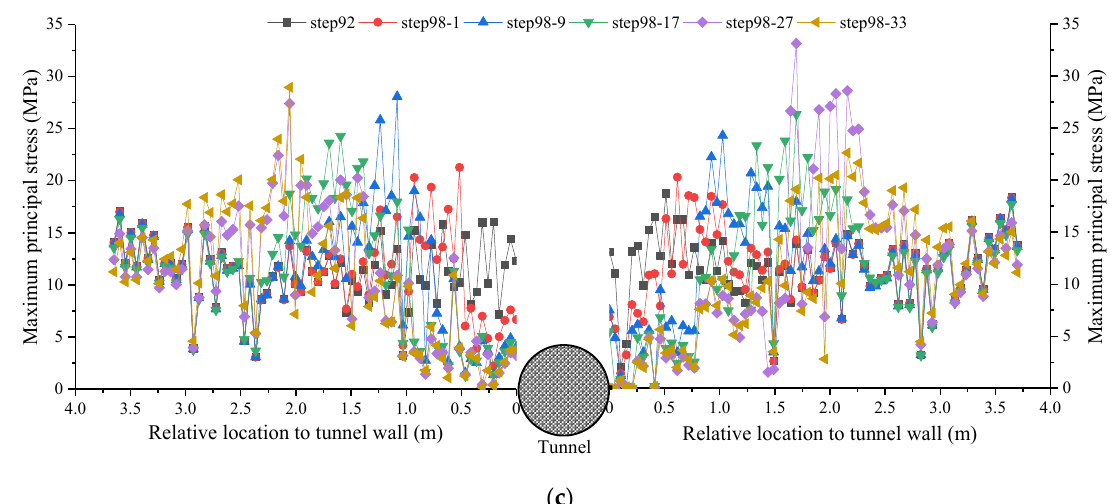
Figure 12. The maximum principal stress transfer process of surrounding rock during zonal disintegration formation in different models: ( a ) Model B0; ( b ) Model B30; ( c ) Model B45.